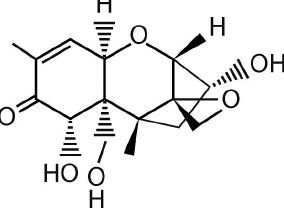
Figure 1 . Deoxynivalenol (DON) structure. Based on Sobrova, et al . [2]. Figure 1. Deoxynivalenol (DON) structure. Based on Sobrova, et al.